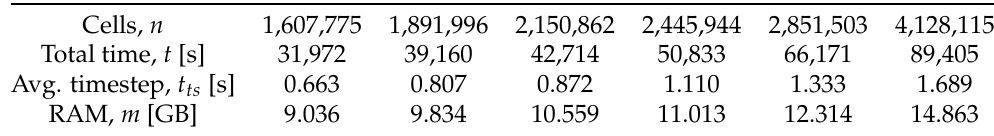
Table A10. Results for setup identical to Table A9 with load balancing enabled and performed when the imbalance reaches 20%.